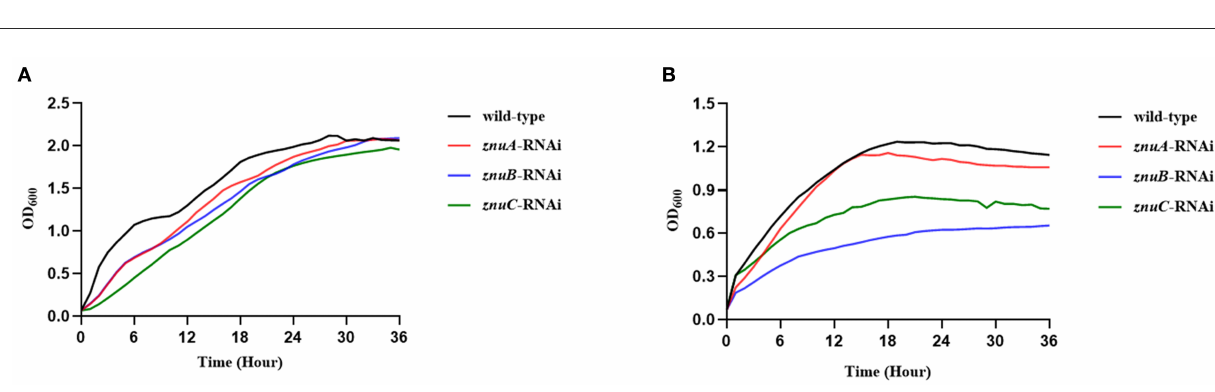
and 3.594 ± 0.36mm, respectively. Statistical analysis revealed a significant 2.09, 2.27, and 2.05 times reduction, respectively in